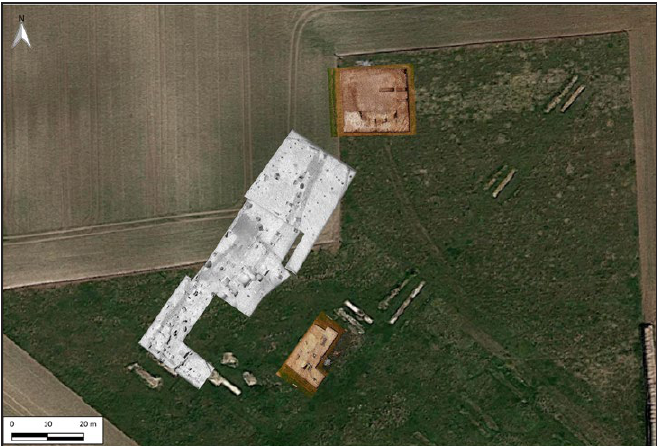
Figure 4: Aerial image, showing the position of the existing excavations 2015–18. [Base layer Google Earth. Rob Kaleta/Downley